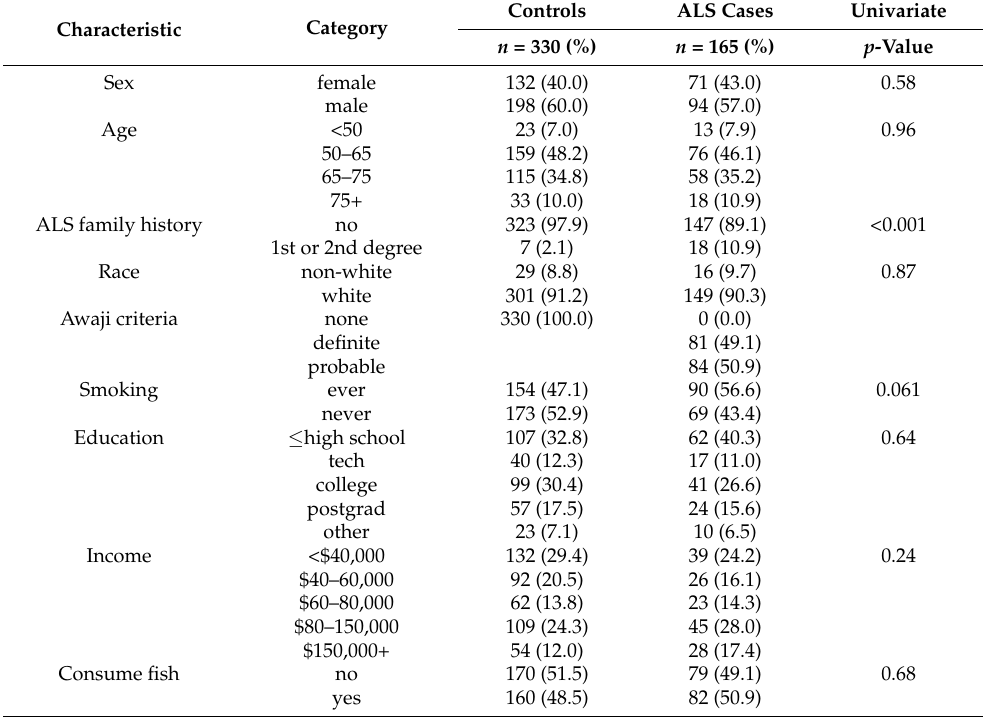
Table 1. Characteristics of ALS cases and